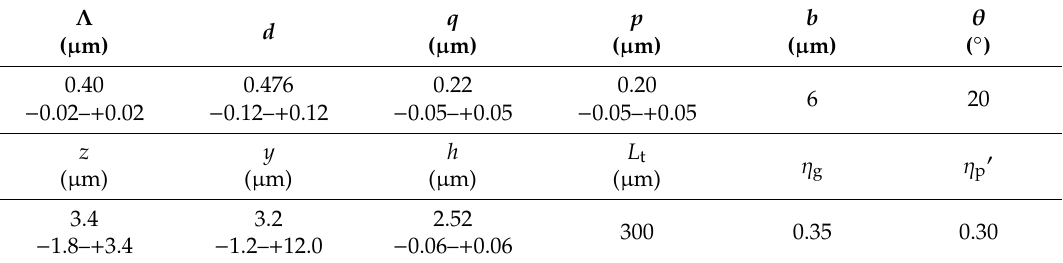
Table 3. Characteristics of the grating